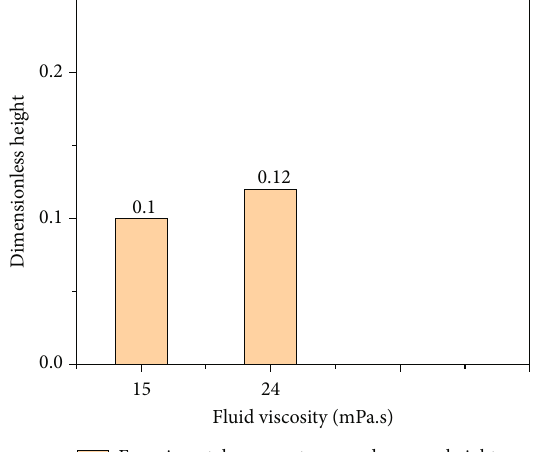
Figure 17: Comparison of results of 40/70 mesh ceramic placement with di ff erent sand-carrying fl uid viscosities.